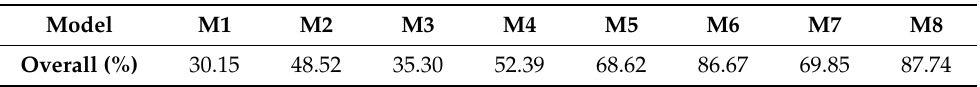
Table 4. Overall test accuracies obtained using sub-dataset for single-stream segmentation models.